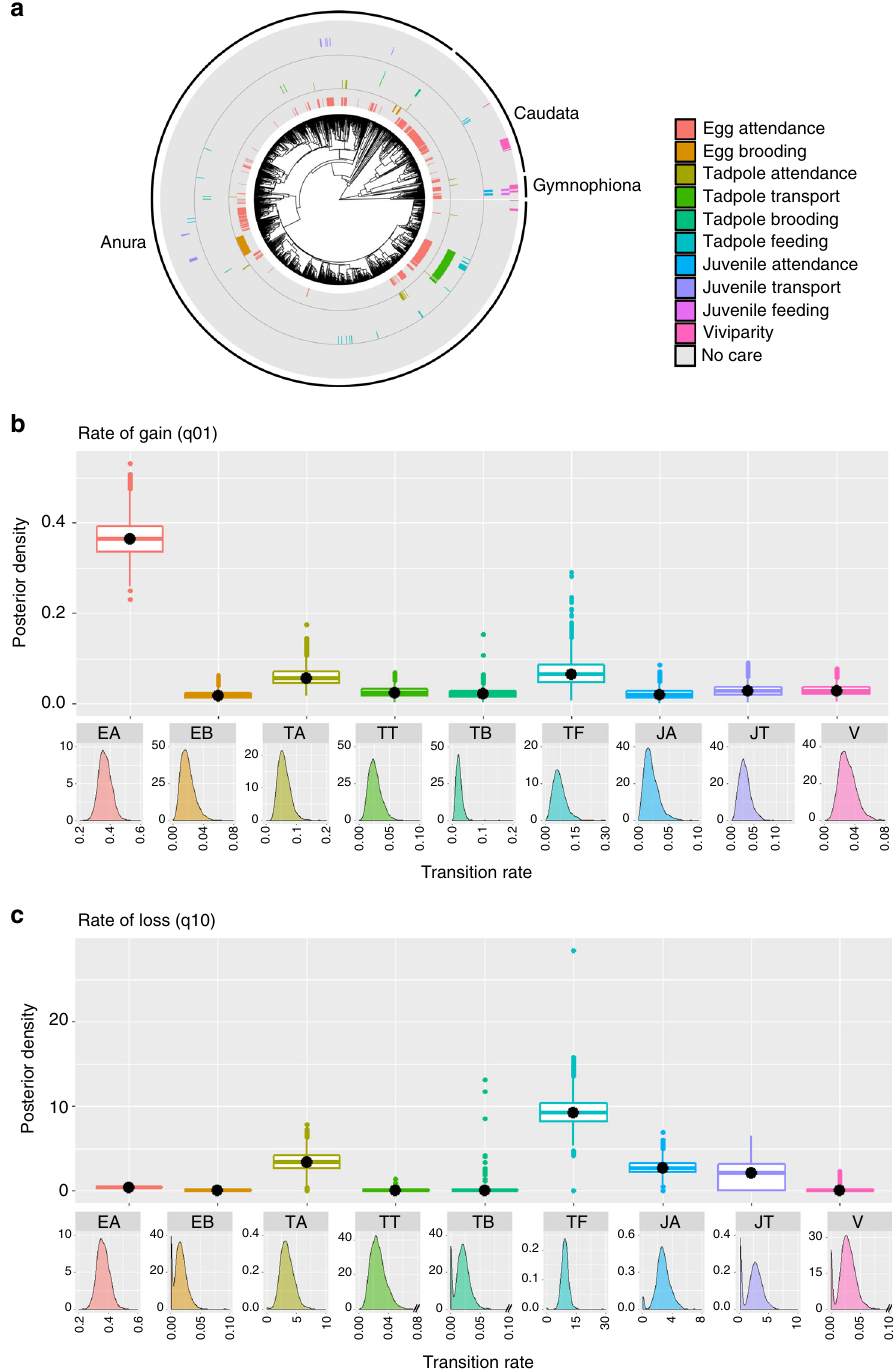
Fig. 1 Evolutionary history of parental care diversity in amphibians. a Distribution of parental care forms in amphibians ( n = 1322 species; sample sizes for each care form in Supplementary Table 1a and Supplementary Fig. 1). The posterior distributions of the RJ Multistate transitions for the b rates of gain (q 01 ) and c rates of loss (q 10 ) of each care form are shown as box plots for comparison, and as posterior density plots for each care form alone. The central black dot in the box plots indicates the median, the box the upper and lower quartiles, the vertical lines the 95% credible intervals of the posterior distributions, and the fi lled dots beyond the lines indicate outlier estimates. Care forms are coded with the same colours across all panels. In b and c : EA egg attendance, EB egg brooding, TA tadpole attendance, TT tadpole transport, TB tadpole brooding, TF tadpole feeding, JA juvenile attendance, JT juvenile transport,